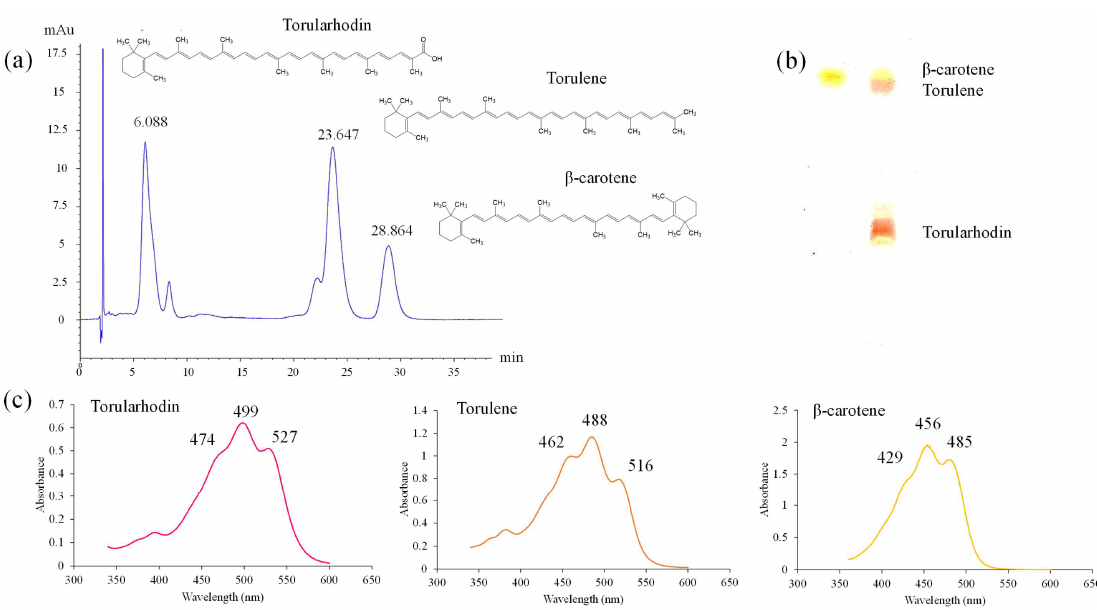
Figure 5. Characterization of pigments produced by S. ruineniae A45.2 ( a ) Separation of pigments by HPLC and ( b ) TLC and ( c ) Visible absorption spectra of the major pigments.